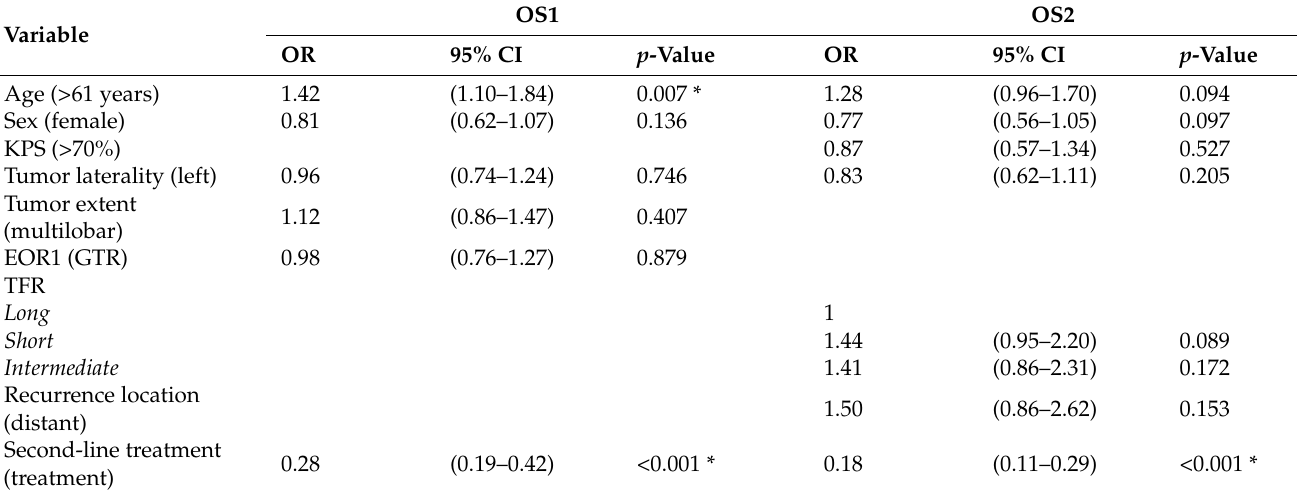
Table 2. Multivariate Cox regression analysis of factors associated with OS1 and OS2 in IDH-wildtype GB patients treated with the Stupp’s regimen in the first line of treatment and subsequently receiving supportive care or treatment after progression. The Cox model for OS1 was stratified for TFR and PFS2 and the Cox model for OS2 was stratified for PFS2, to satisfy the assumption of proportional hazards.